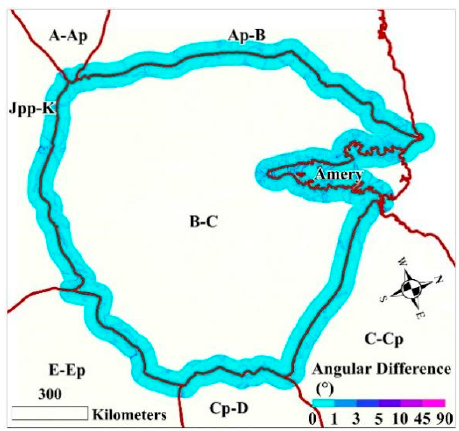
Figure 14. Direction accuracy of B-C Basin buffer zone. Table 4. Cumulative frequency of the direction accuracy on B-C Basin buffer zone. Angular Difference ( ° )